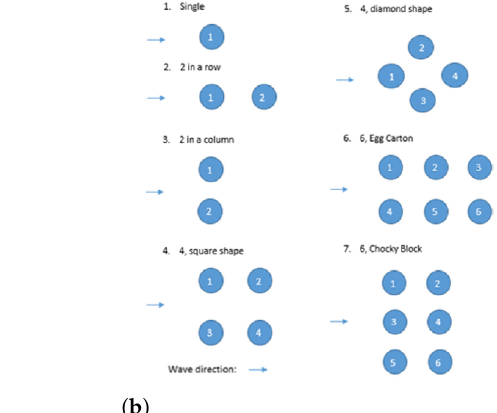
Figure 11. Experimental setup used by Nader et al., reprinted with permission from Ref. [9], 2017, Nadar et al.: ( a ) WEC array layout; ( b ) sketches of tested WEC array